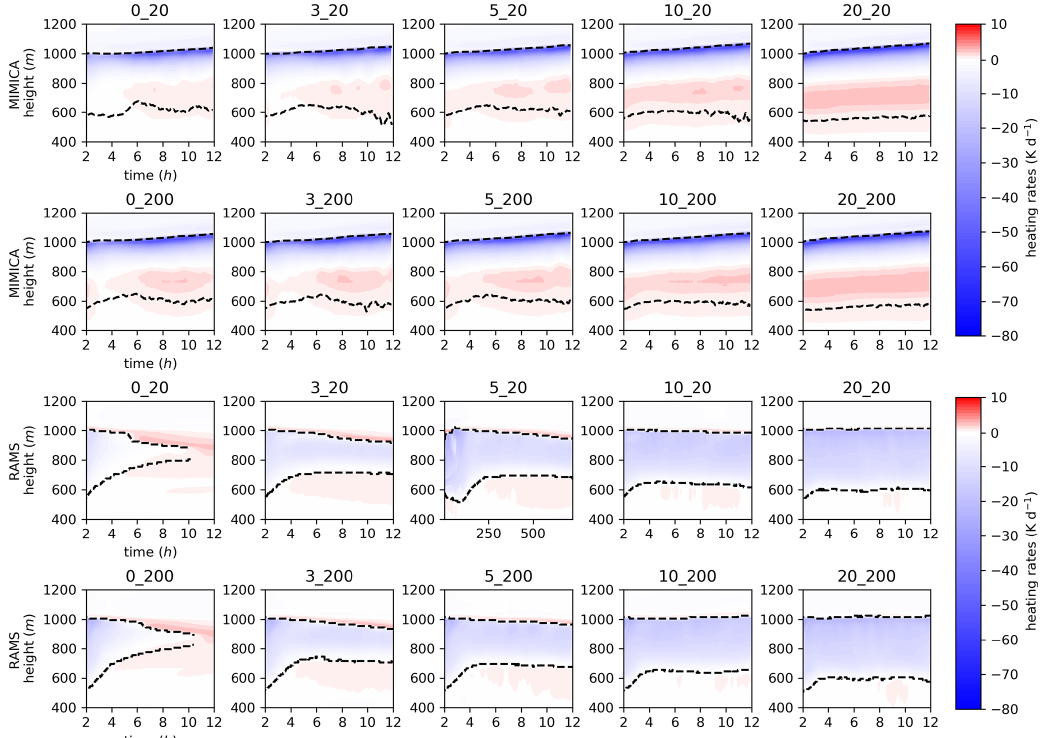
Figure A2. Radiative heating rates for the MIMICA and RAMS simulation sets. The first 2h of simulations, considered as the spin-up period, are excluded. For figure clarity, the plot titles have been abbreviated; the first number refers to the accumulation mode and the second to the Aitken mode concentration in cubic centimetres, i.e. 0_20 refers to AC0_AK20. Black dashed lines represent the cloud top and cloud base heights.